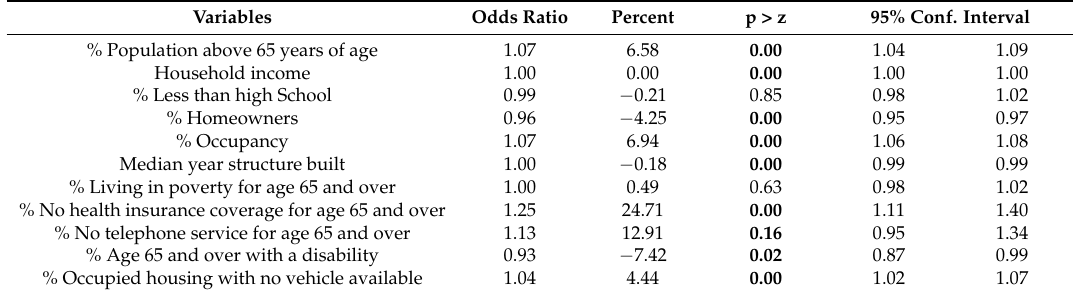
Table 3. Regression analysis of census tracts in coastal counties based on the level of rurality.